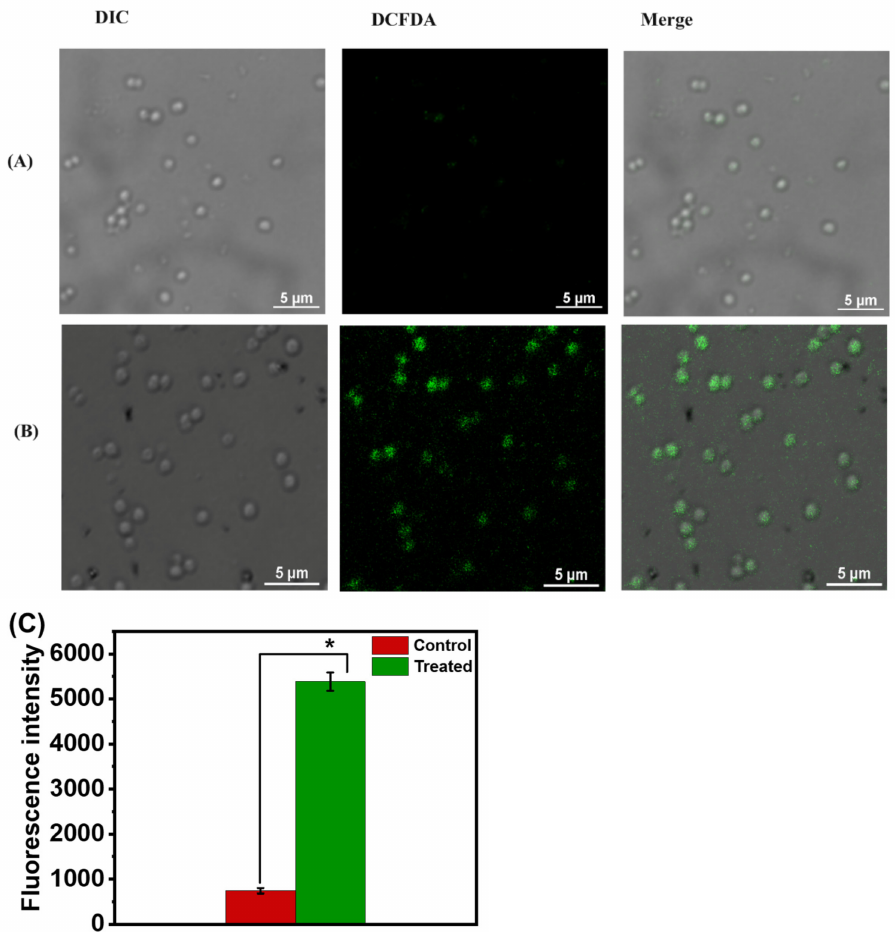
Figure 8. Intracellular ROS was measured by DCFDA staining after rGO-S/Se (200 µ g/mL) treatment. Representative fluorescence images of S. aureus ( A ) without NPs and ( B ) with NPs. ( C ) is the quantified data of ( A , B ) where the control is S. aureus without NPs and treated is S. aureus after 8 h of NPs exposure, Scale bar = 5 µ m. The intensity of the green fluorescence indicates ROS concentration in the cells. Error bar represents the standard error of the mean. * p -value <